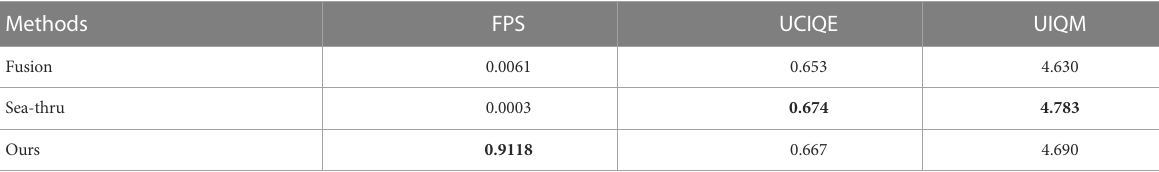
TABLE 6 Quantitative evaluation on 7968×5312 images.